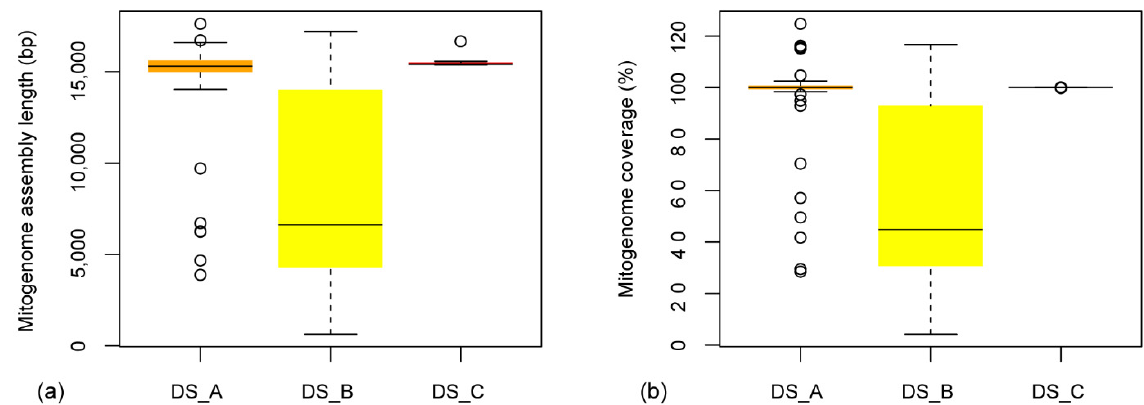
Figure 2. ( a ) Mitogenome assembly length and ( b ) coverage for three datasets.